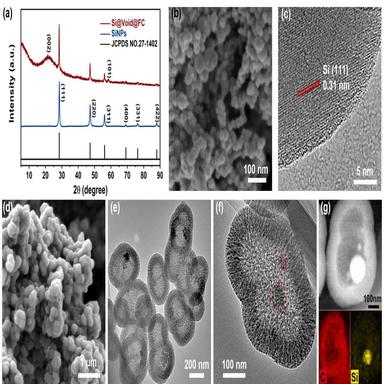
Structural characterizations of silicon nanoparticles and Si@Void@FC. (a) XRD, (b,d) SEM, (c, e–f) TEM and HR-TEM images, and (g) EDS mapping (yellow and red represent silicon and carbon, respectively).